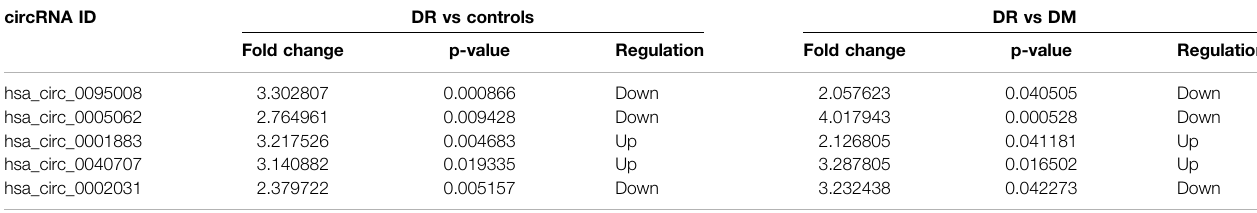
TABLE 2 | List of differentially expressed circRNAs in patients with DR.